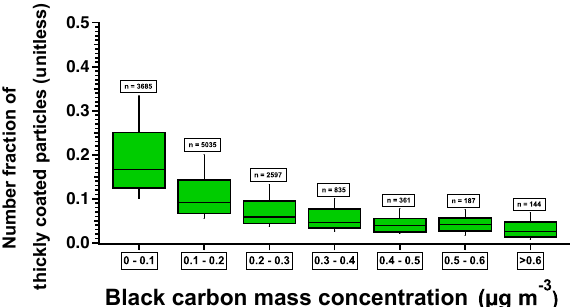
Figure 9. Number fraction of rBC that is thickly coated vs. rBC mass concentration (µgm − 3 ) for measurements made in Redlands, California. Boxes and whiskers summarize data at 1min resolution. Boxes depict the 25th and 75th percentiles, whiskers depict the 10th and 90th percentiles, and the horizontal lines within the boxes show the median. The text boxes indicate the number of data points in each bin. Number fraction of rBC that is thickly coated and rBC mass concentration are anti-correlated with correlation coefficient r = − 0 .